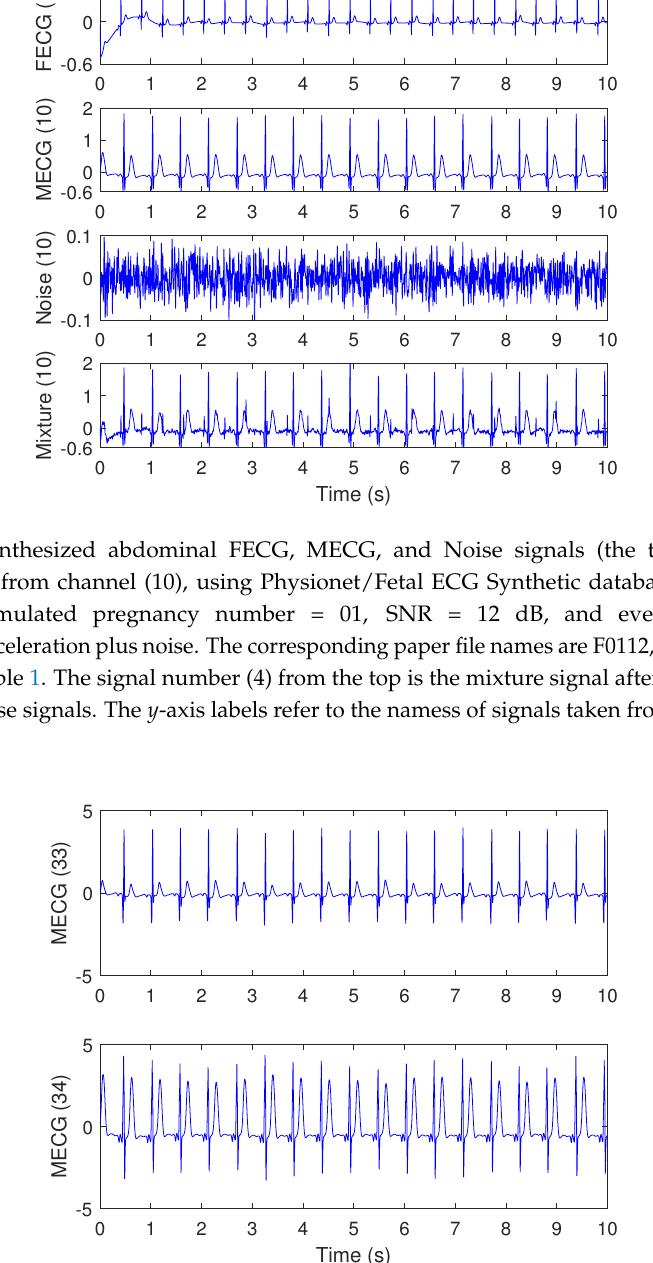
Figure 14. Synthesized maternal reference ECG (MECG) signals, taken from channels (33 and 34), using Physionet/Fetal ECG Synthetic database (FECGSYNDB)—assuming the same simulation settings used in Figure 13. The corresponding paper file name is M0112, according to Table 1. The y -axis labels refer to the names of two signals taken from channels 33 and